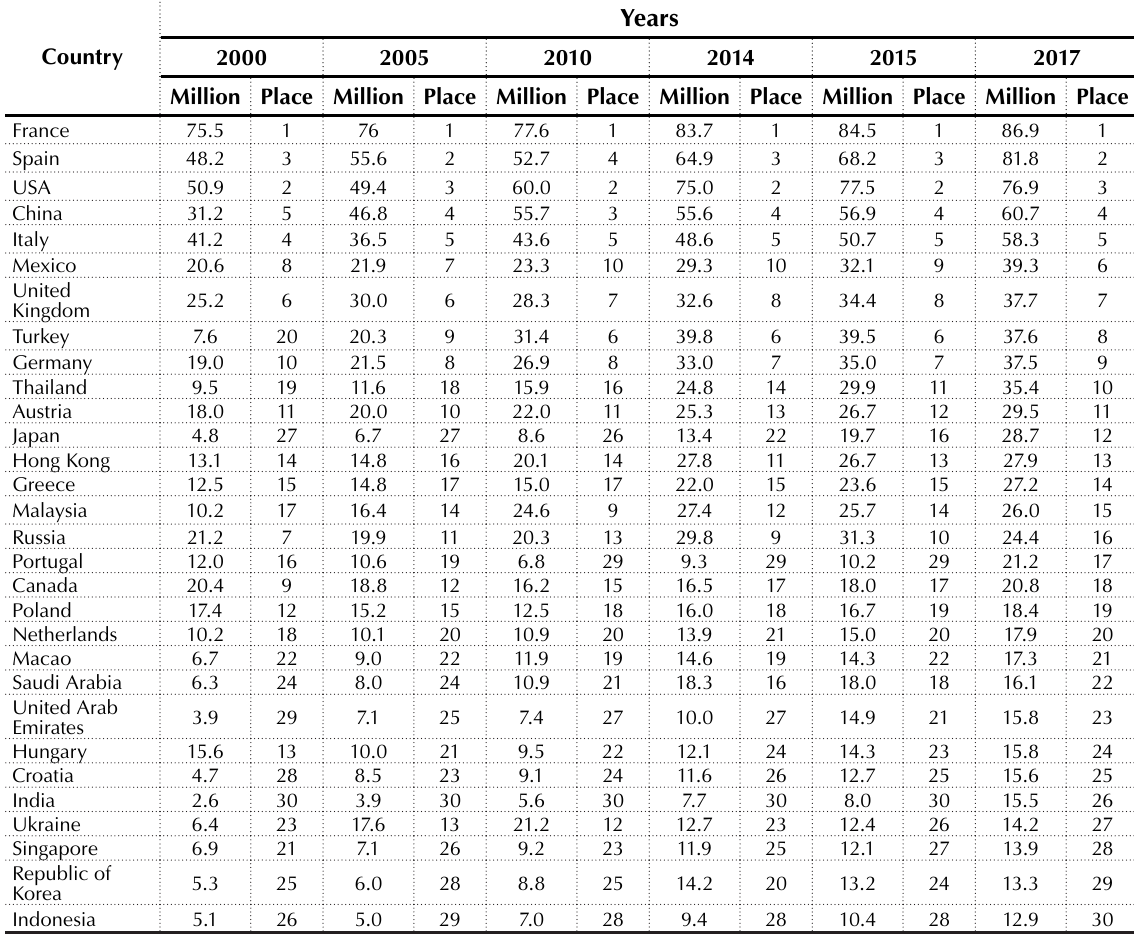
Table 3. TOP-30 country by indicators of tourist arrivals, 2000–2017 Source: Build by the authors based on the materials from Tourism Highlights